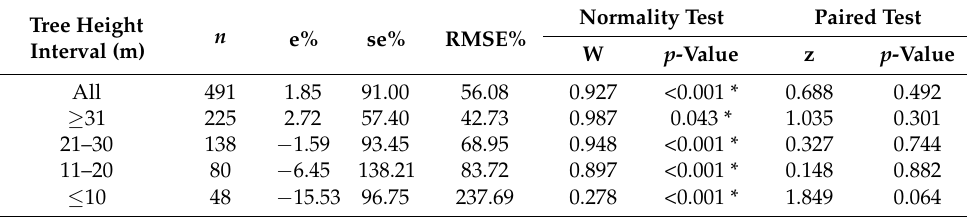
Table 7. Differences between the calculated volumes of measured and detected trees.